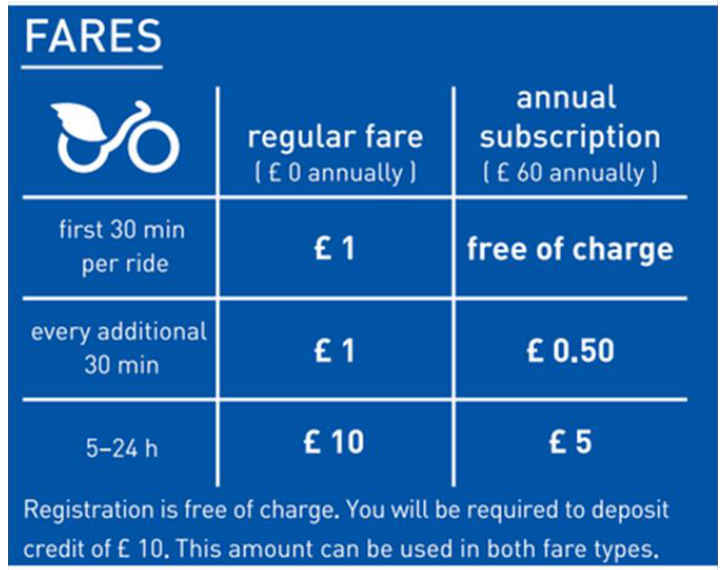
Figure 6. Nextbike cost structure. Source: Nextbike